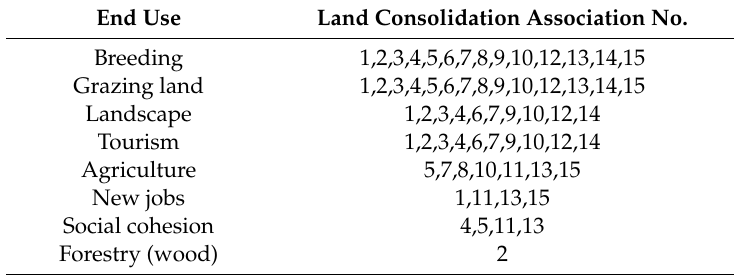
Table 5. End use of territorial associate management by land consolidation